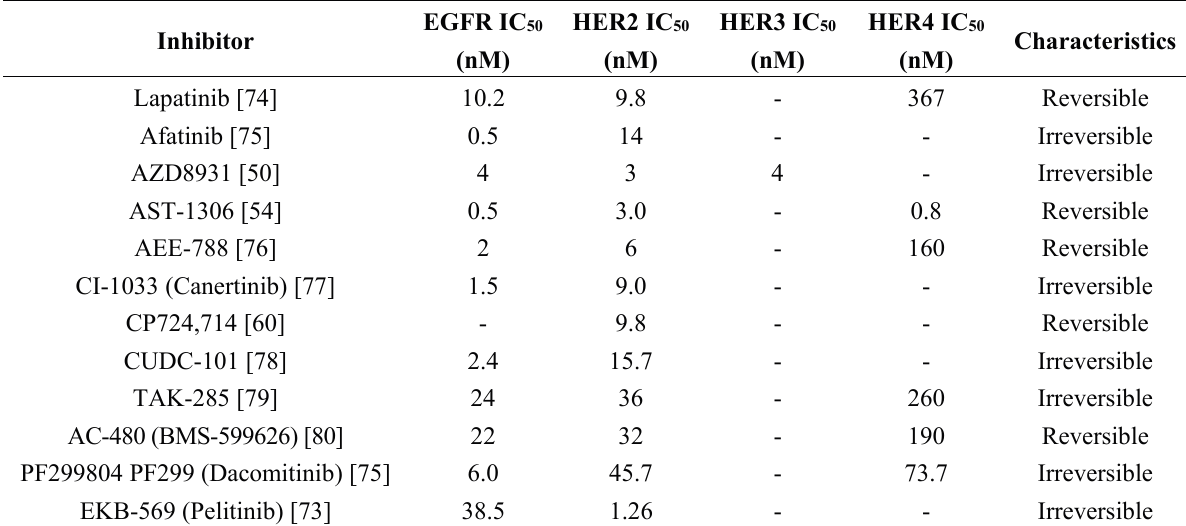
Table 2. Specificity profiles of HER2 kinase inhibitors.